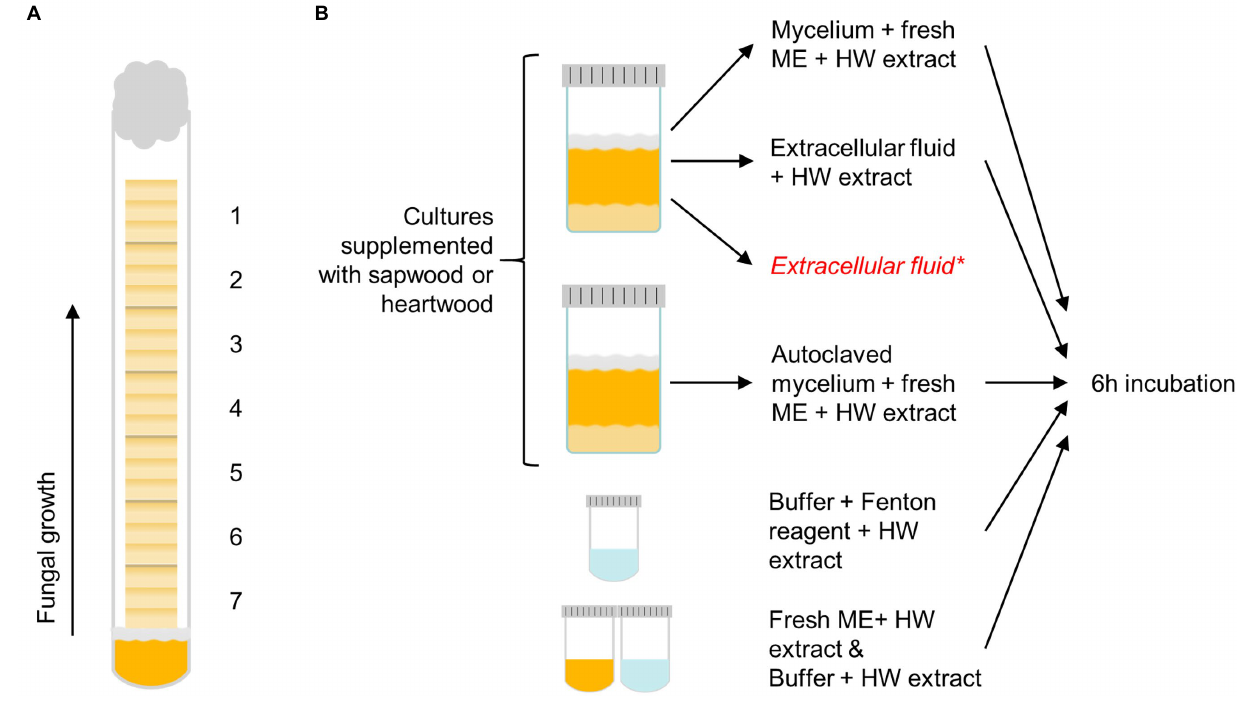
FIGURE 1 | The decay test set-up with sample positions 1–7 labelled (A) and the outline of the extract degradation assays (B) . Pine heartwood (HW) extract was incubated with mycelium or extracellular fluid from Coniophora puteana and Rhodonia placenta liquid cultures (supplemented with sapwood or heartwood powder), or with Fenton reagent. Extract was also incubated with autoclaved mycelium, fresh malt extract broth (ME), or buffer to act as references for the mycelium, extracellular fluid, and Fenton reagent incubations, respectively. *An additional control sample of extracellular fluid was collected from heartwood cultures and analysed immediately without incubation to determine the concentration of solubilised